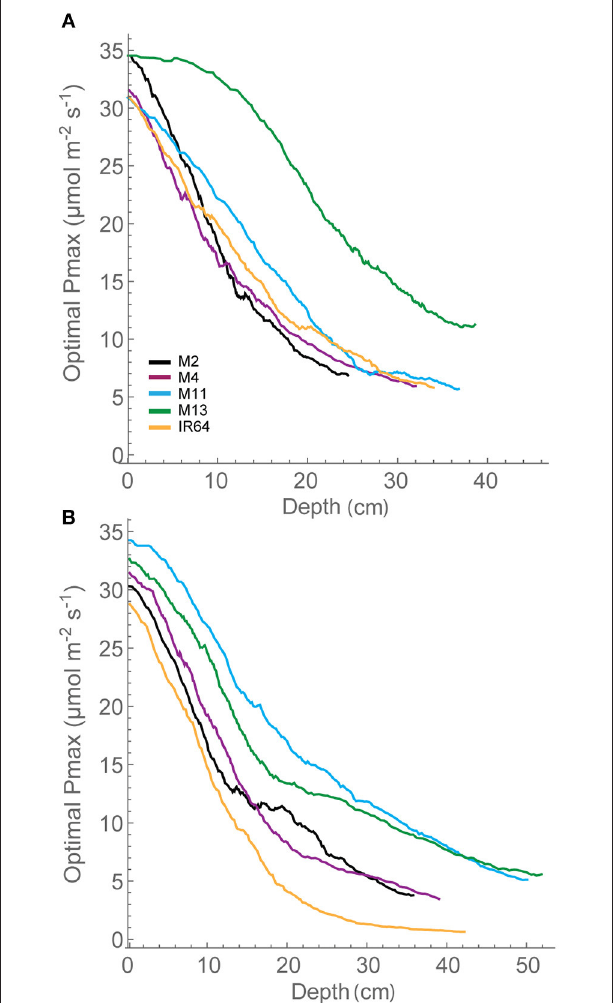
FIGURE 5 | Whole canopy acclimation model output. The acclimation model was run at 250 locations throughout canopy depth to predict the optimal P max at each location throughout canopy depth (i.e., from the top of the canopy) dependent upon the light environment that it experienced, calculated via ray tracing. A moving average has been fitted to the data. (A) GS1 and (B) GS2. M2, M4, M11, and M13 refer to Shan-Huang